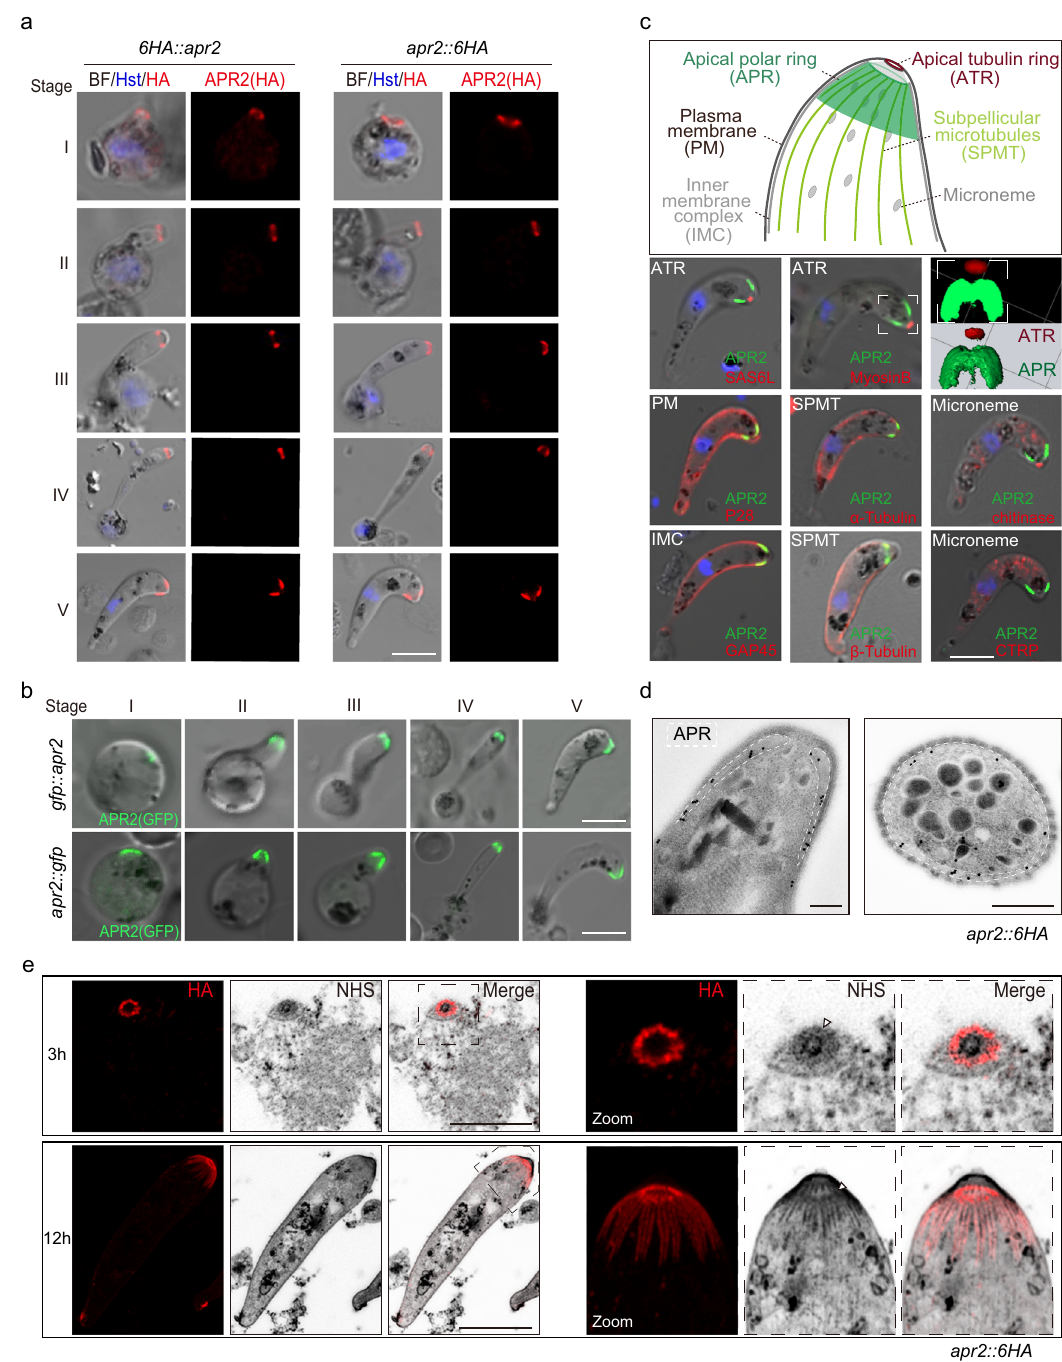
Fig. 2 | APR2 localizes at APR throughout zygote to ookinete development. a IFAofAPR2expressionduringzygote(stageI)toookinete(stageV)development of two HA-tagged strains 6HA::apr2 (left panel) and apr2::6HA (right panel). Three independently performed experiments with similar results. Scale bars: 5 μ m. b Fluorescence detection of APR2 in living parasites during zygote to ookinete developmentoftwoGFP-taggedstrains gfp::apr2 (toppanel)and apr2::gfp (bottom panel).Twoindependentlyperformedexperiments withsimilarresults. Scalebars: 5 μ m. c Co-localization analysis by IFA for APR2 with proteins of known cellular localizations in ookinetes. P28 (plasma membrane, PM), GAP45 (inner membrane complex, IMC), α - and β -Tubulin (subpellicular microtubule, SPMT), MyosinB and SAS6L (apical tubulin ring, ATR), chitinase and CTRP (microneme). Top panel showsa diagram of apical structureof ookinete.APR2is tagged with a 6HA. SAS6L